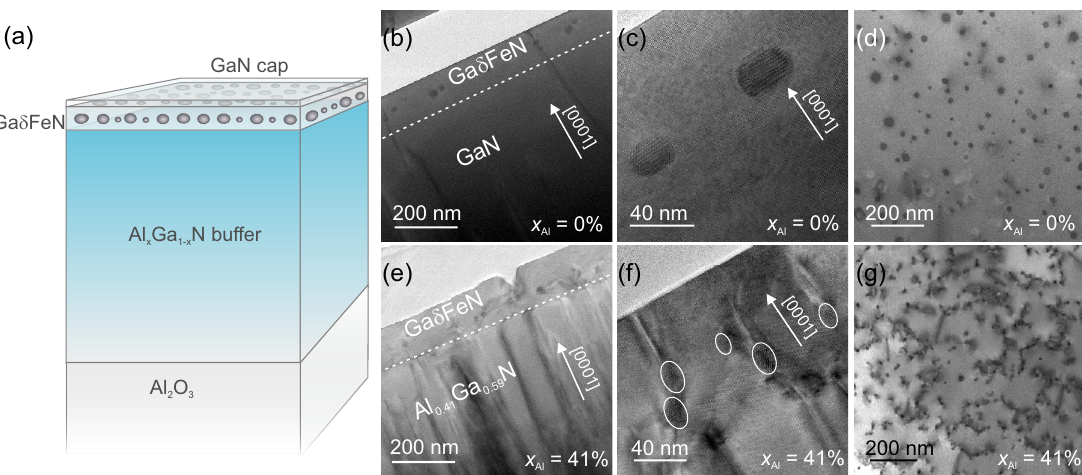
Figure 1. ( a ): Architecture of the investigated samples. Cross-section TEM micrographs of the samples grown ( b , c ): on GaN, and ( e , f ): on Al 0.41 Ga 0.59 N buffers, showing the embedded nanocrystals distributed in the Ga δ FeN layer. ( d , g ): Plan-view TEM images of the two samples, revealing an increased dislocation network for the layer grown on the Al 0.41 Ga 0.59 N buffer with respect to the layer grown on